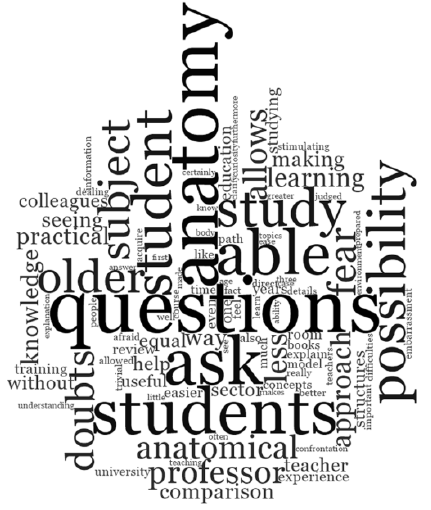
Figure 3. Word cloud representing tutors’ responses to the open-ended question: “What were the strengths of this near-peer tutoring model?”